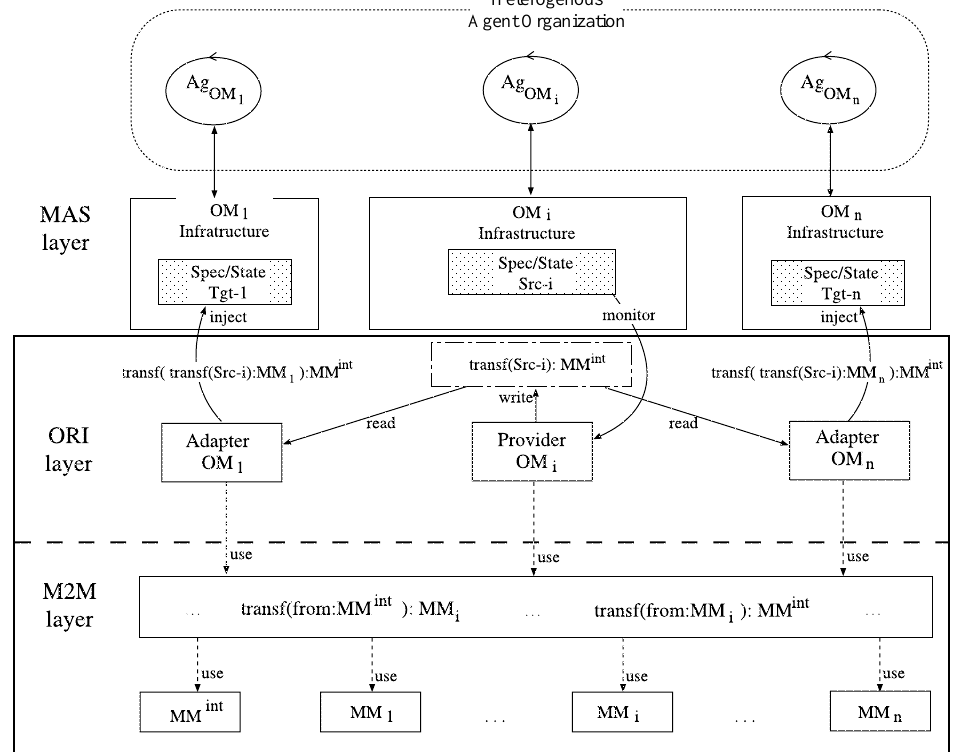
Figure 10. MAORI framework (redesigned from